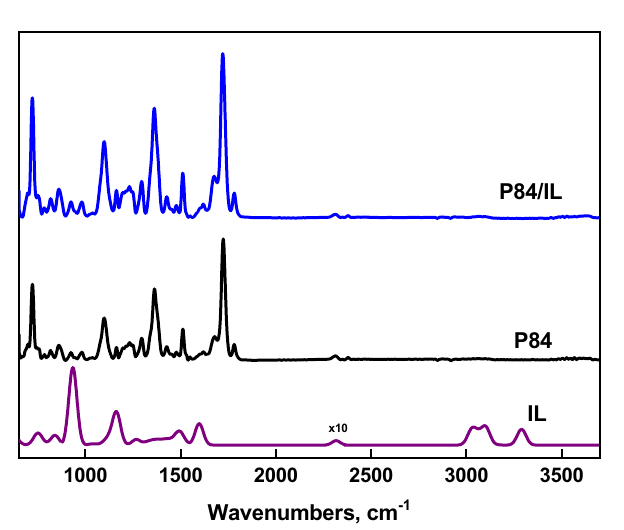
Figure 6. ATR-FTIR spectra of IL, P84 and P84/IL